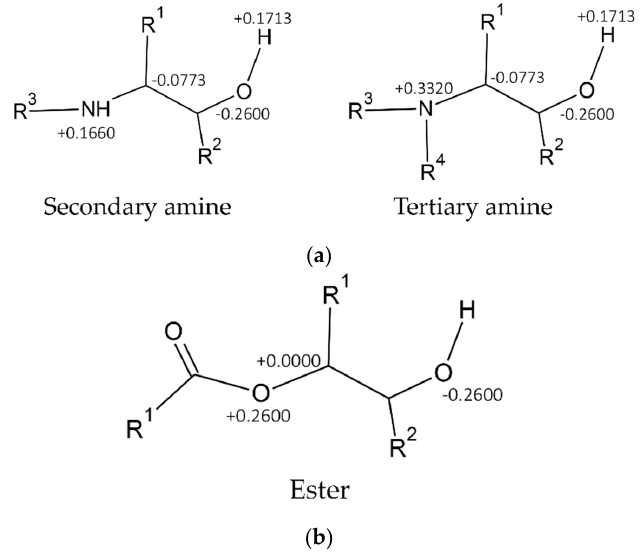
Figure 3. Charge update (increments) for atoms after the cross-linking process with: ( a ) polyamine hardeners (DETA); ( b ) anhydride hardeners (MeTHPA). Table 1. Summary and features of the molecular models studied.